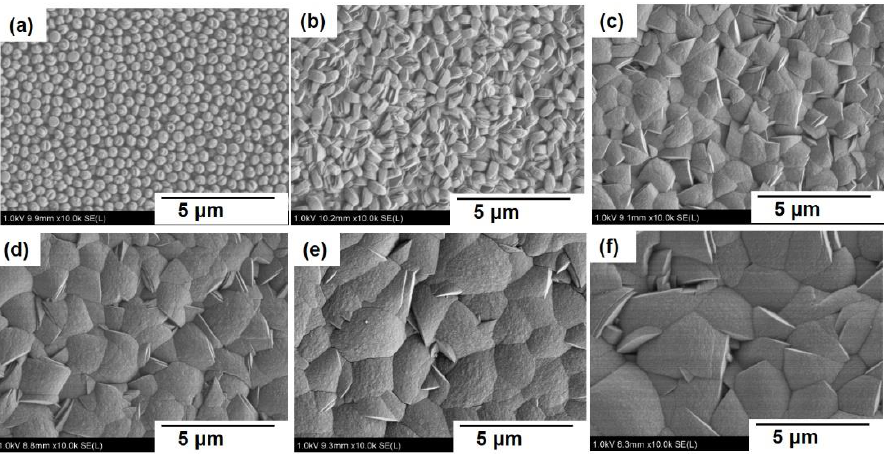
Figure 1. Typical FE-SEM images of surface of ( a ) a seeded support and silicalite-1 membranes crystallized for ( b ) 72, ( c ) 120, ( d ) 168, ( e ) 252, and ( f ) 336 h.